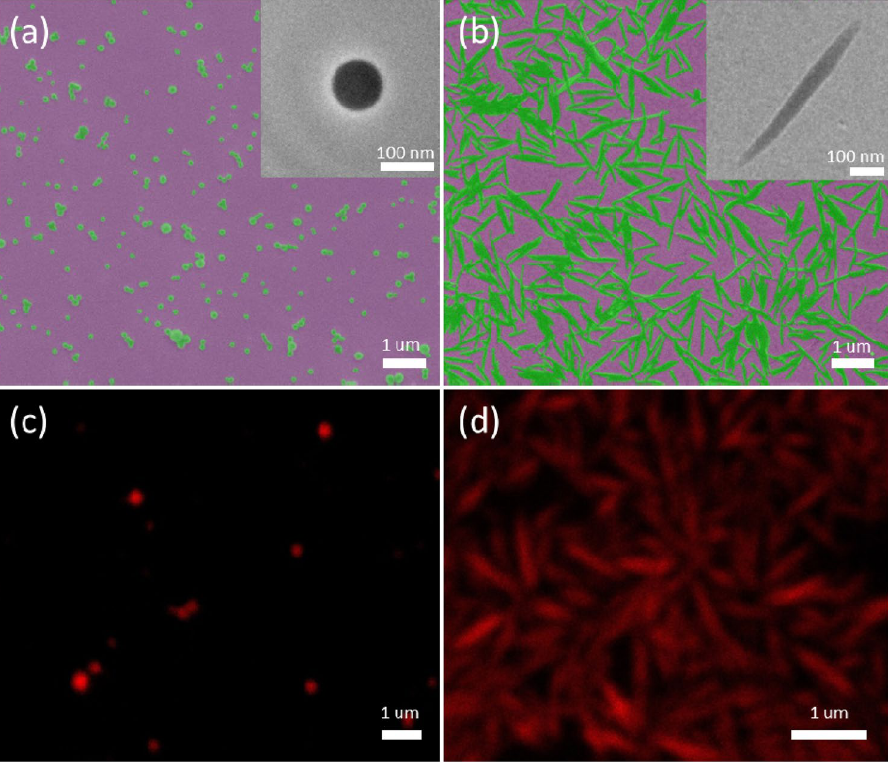
Figure 1. PLGA-PEG NPs with different shapes. SEM images of ( a ) spherical-shaped and ( b ) needle-shaped PLGA-PEG NPs, insert are the magnified TEM images; ( c,d ) Corresponding confocal images showing the fluorescence coming from incorporated Nile Red